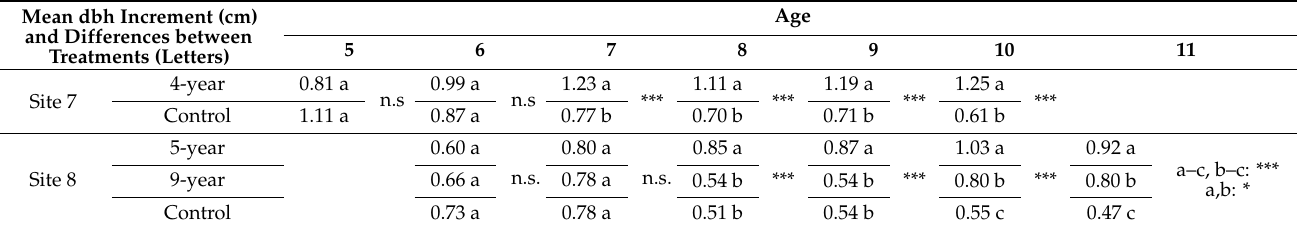
Table 4. Variation of the mean dbh increment across sites, treatments and monitoring years. p -value levels of the ANOVA and Tukey tests are indicated next to the mean values (***: p -value < 0.001, *: 0.01 < p -value < 0.05, n.s. (nonsignificant): p -value > 0.05). Significantly different groups are noted with